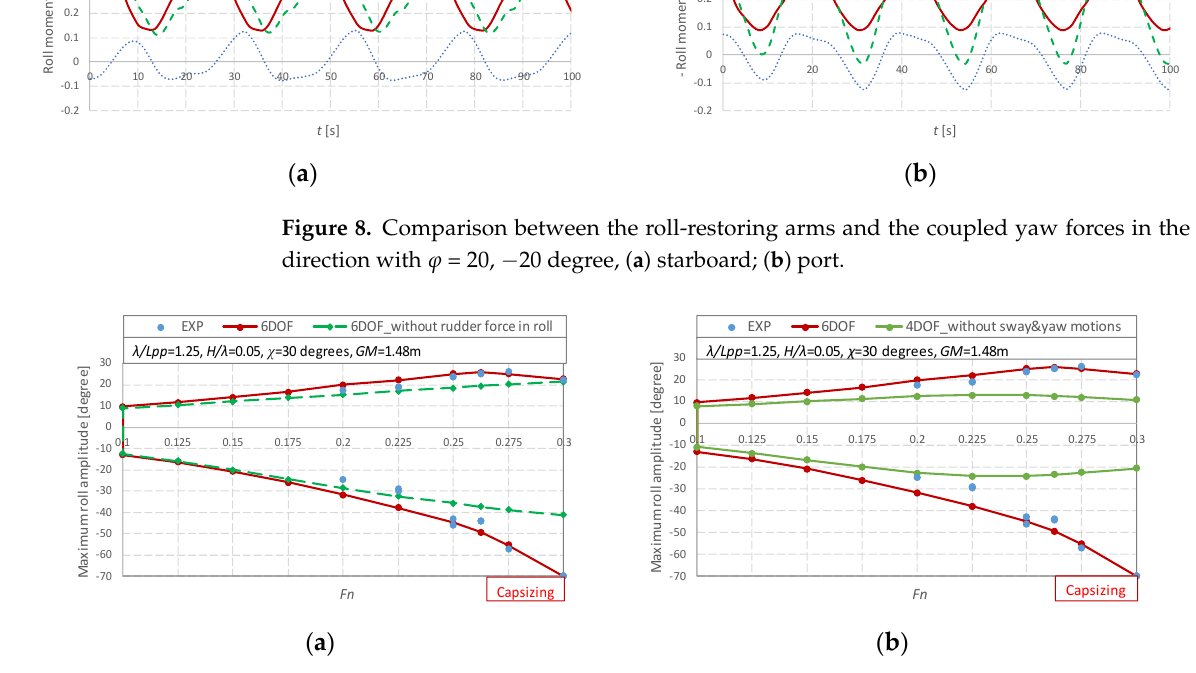
Figure 9. Comparison of roll angles between the numerical results and test results without and with